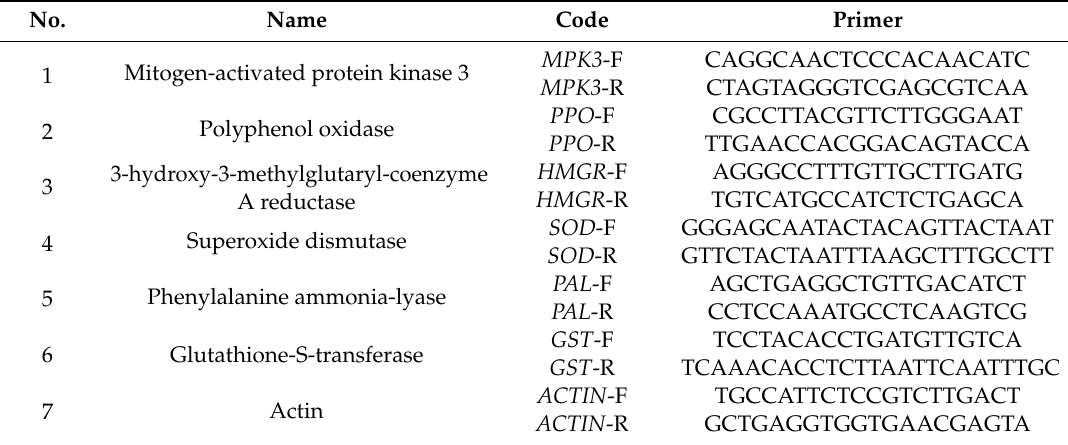
Table 2. List of primers used to study the transcriptional regulation of defense-related genes in tomato.